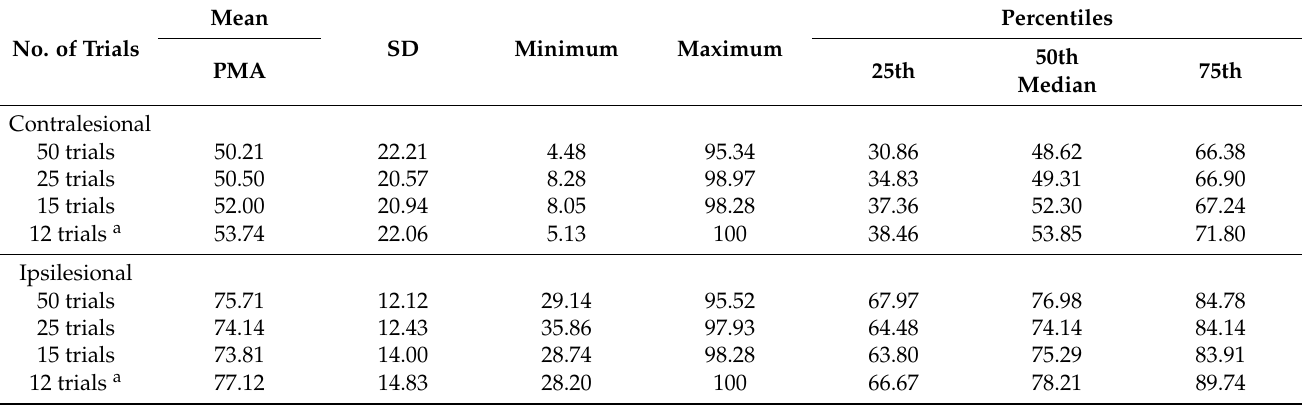
Table 4. Descriptive statistics for the contralesional and ipsilesional hand of stroke survivors based on original and brief test versions of the